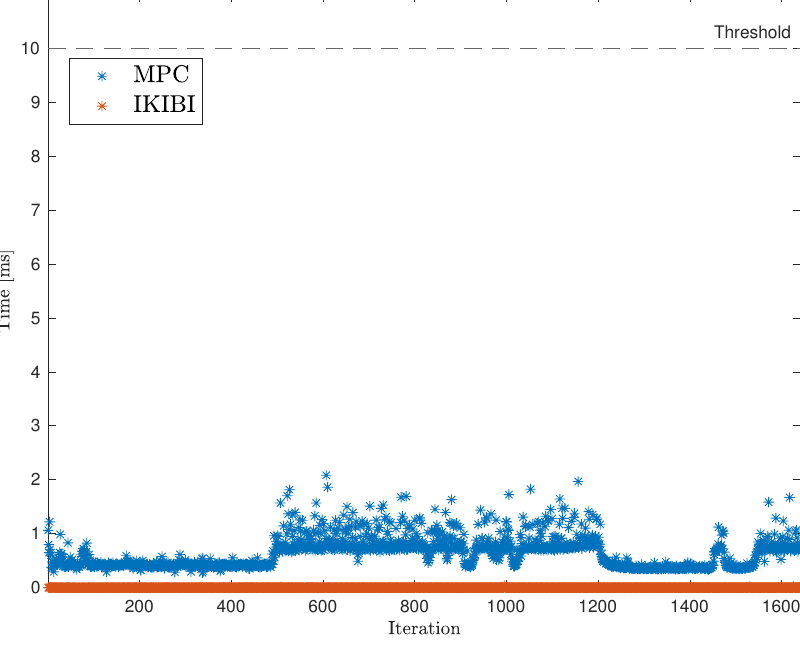
Figure 2. Calculation duration throughout the